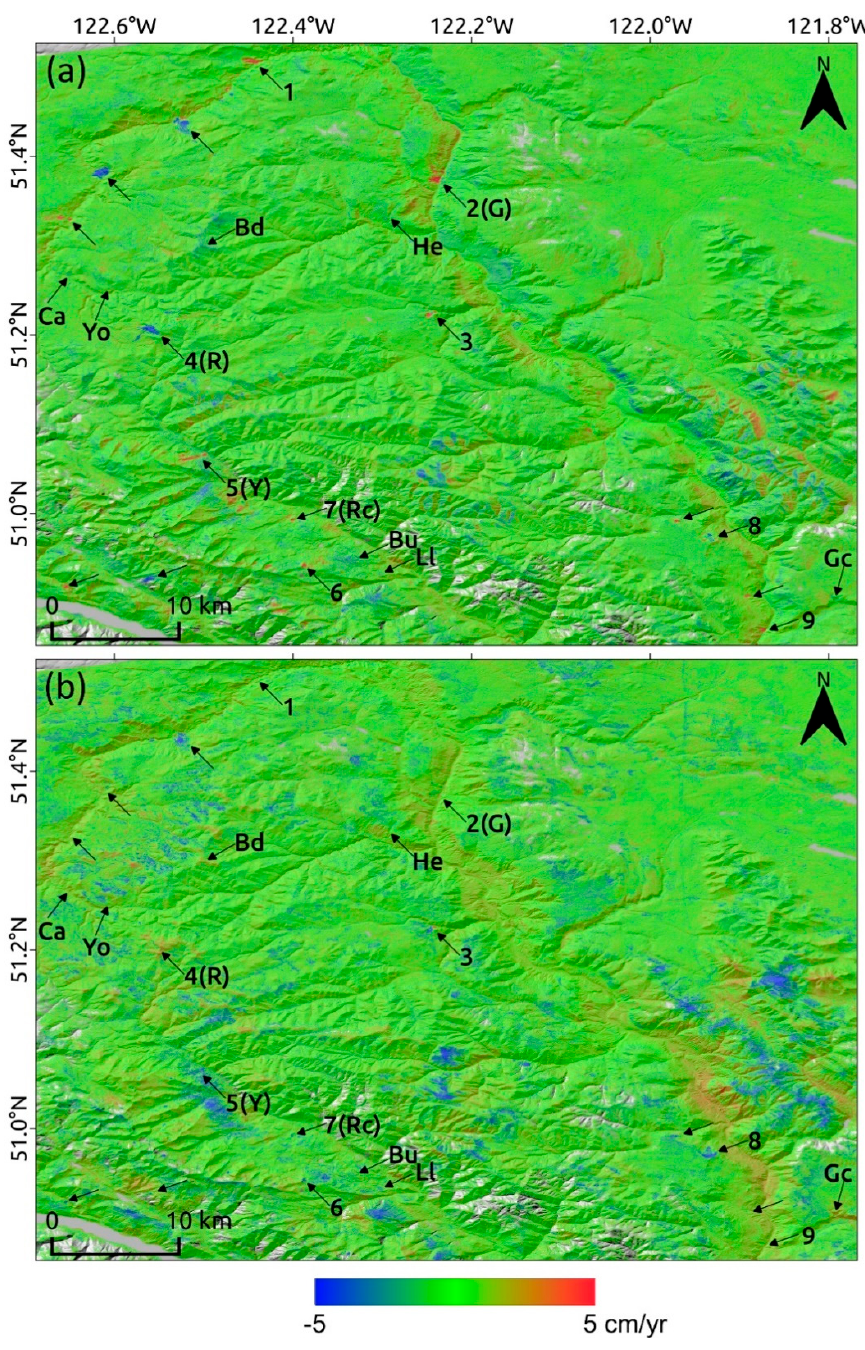
Figure 3. Linear deformation rate maps of east–west ( a ) and vertical ( b ) movements from October 2017 to June 2021. The black arrows point to potential slope movements. The numbers are the sites discussed in Figures 4–6. The abbreviations are the earthflows reported from [32,41]: G=Grinder Creek; He=Heginbottom Creek; Bd=Black Dome; Ca=Canyon; Yo=Yodel; R=Red Mountain; Y=Yalakom River; Rc=Retaskit Creek; Bu=Burkholder Creek; Ll=Lac La Mer; Gc=Gillon Creek. The 2D linear deformation rate map files are provided in the Supplementary Materials.